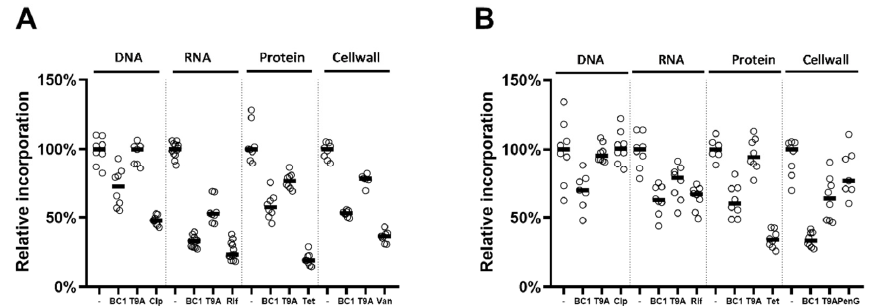
Figure 2. Effects of BC1 and T9A on the four major macromolecular synthesis pathways of B. subtilis ( A ), and X. citri ( B ), in comparison to negative controls ( − ) and antibiotics with specific activities targeting DNA, RNA, Protein, and Peptidoglycan syntheses, Ciprofloxacin (Cip), Rifampicin (Rif), Tetracycline (Tet), and (A) Benzyl penicillin (PenG), (B) Vancomycin (Van), respectively.